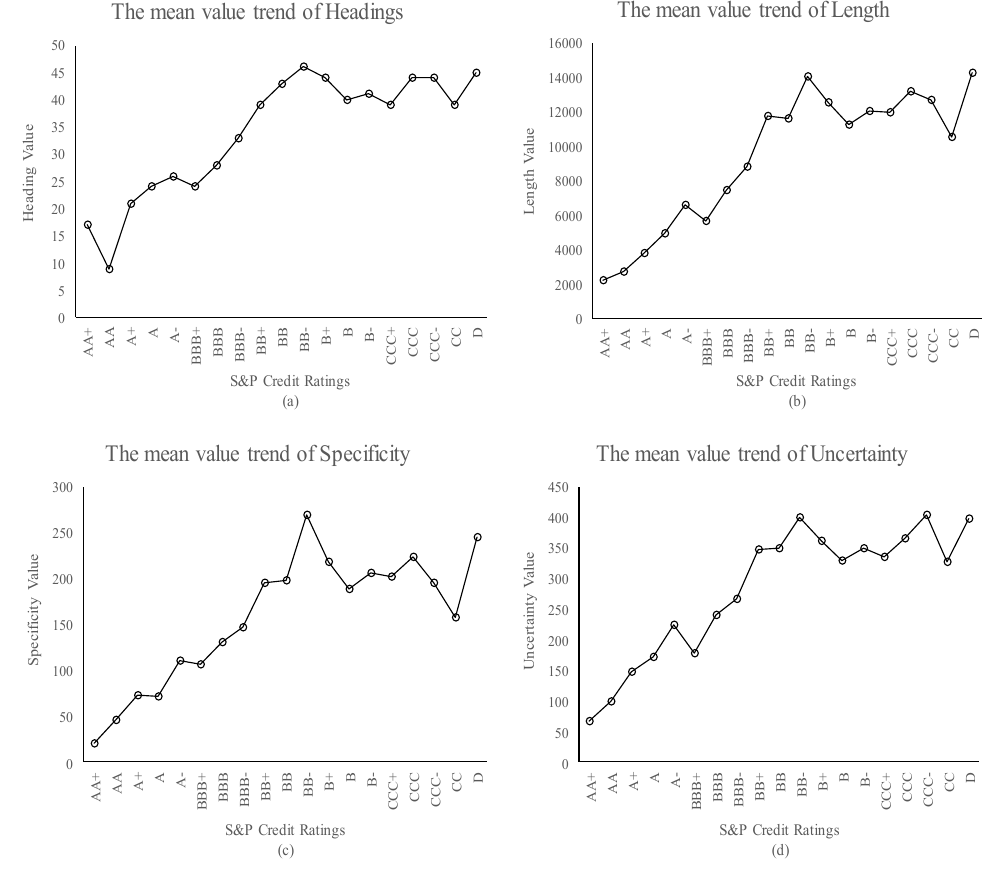
Figure 1. The four internal textural risk measures of different rating grades. Table 2. Four internal textual risk measures’ mean values located at each credit rating.